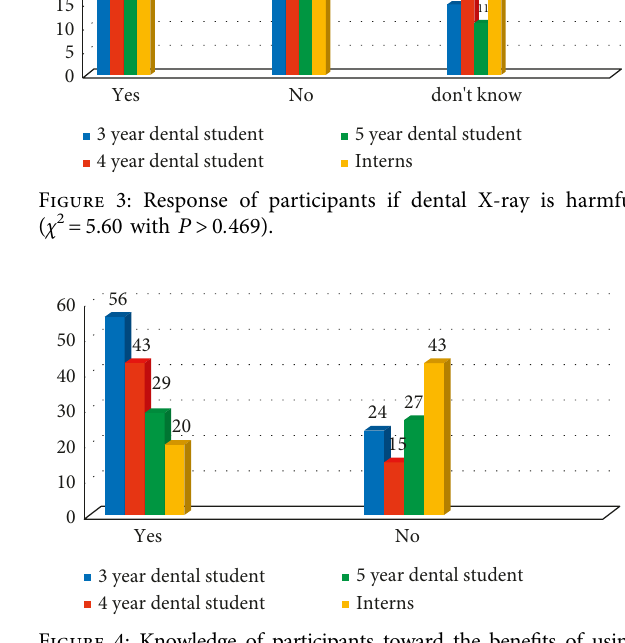
29.55 with P 0 . 01). (cid:31) ≤